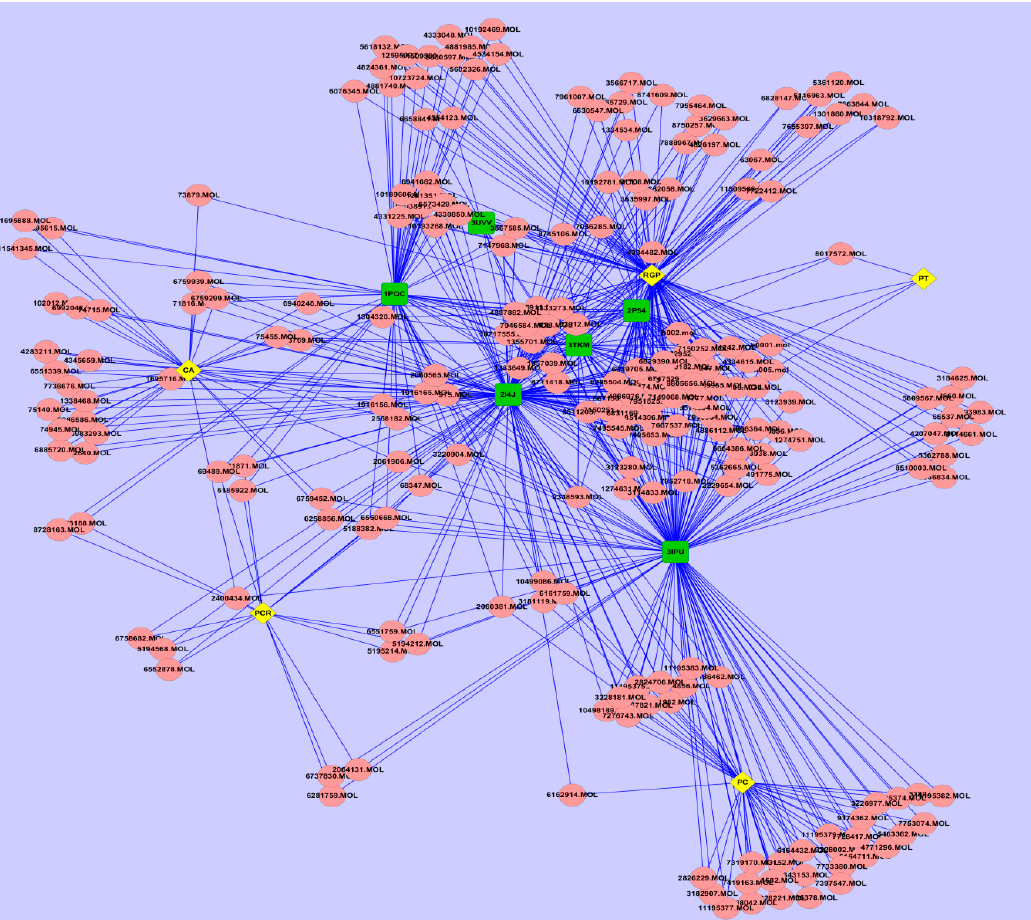
Figure 2. The herb-compound-target network: the pink round nodes refer to compounds from herbs; the yellow rhombic nodes represent herbs; the green quadrate nodes represent targets.